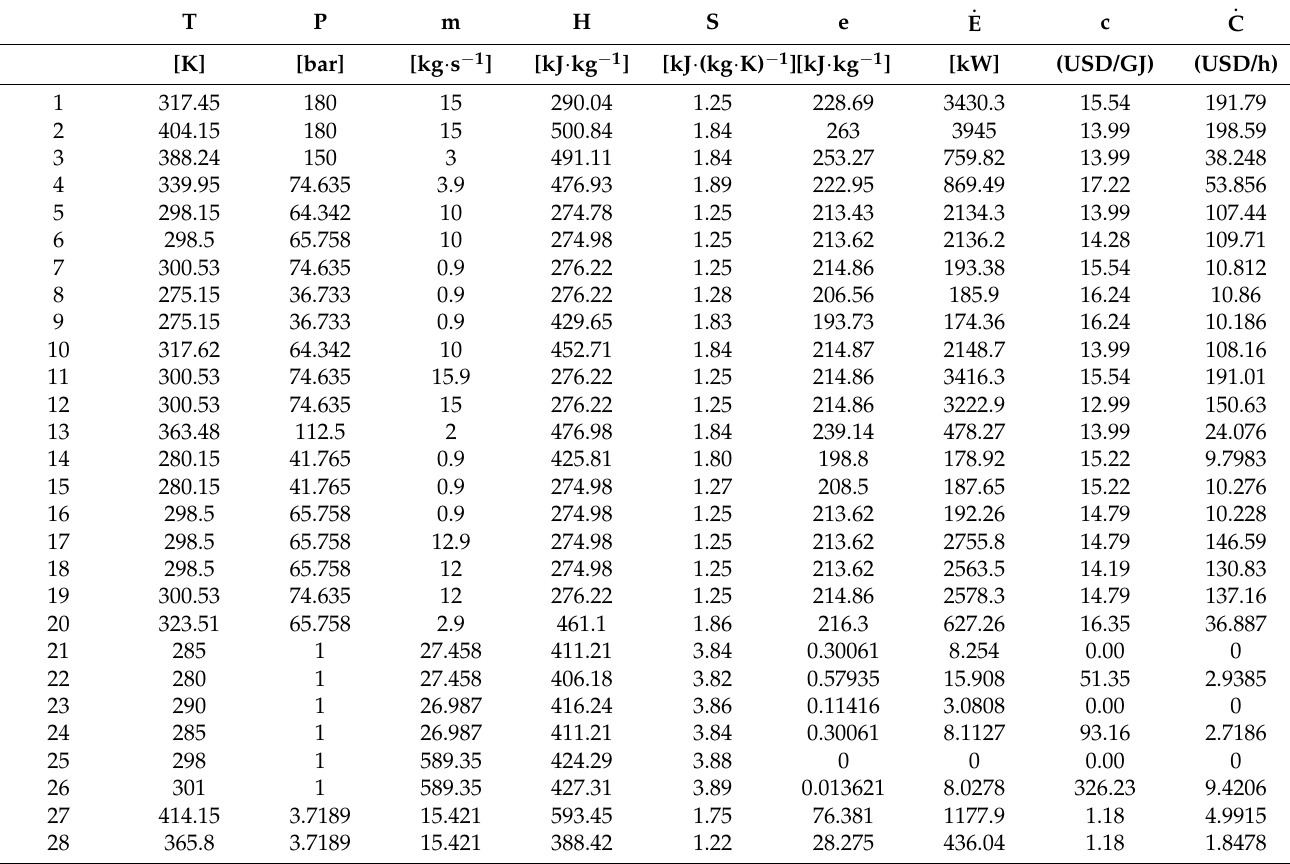
Table 11. Thermodynamic properties and stream costs.